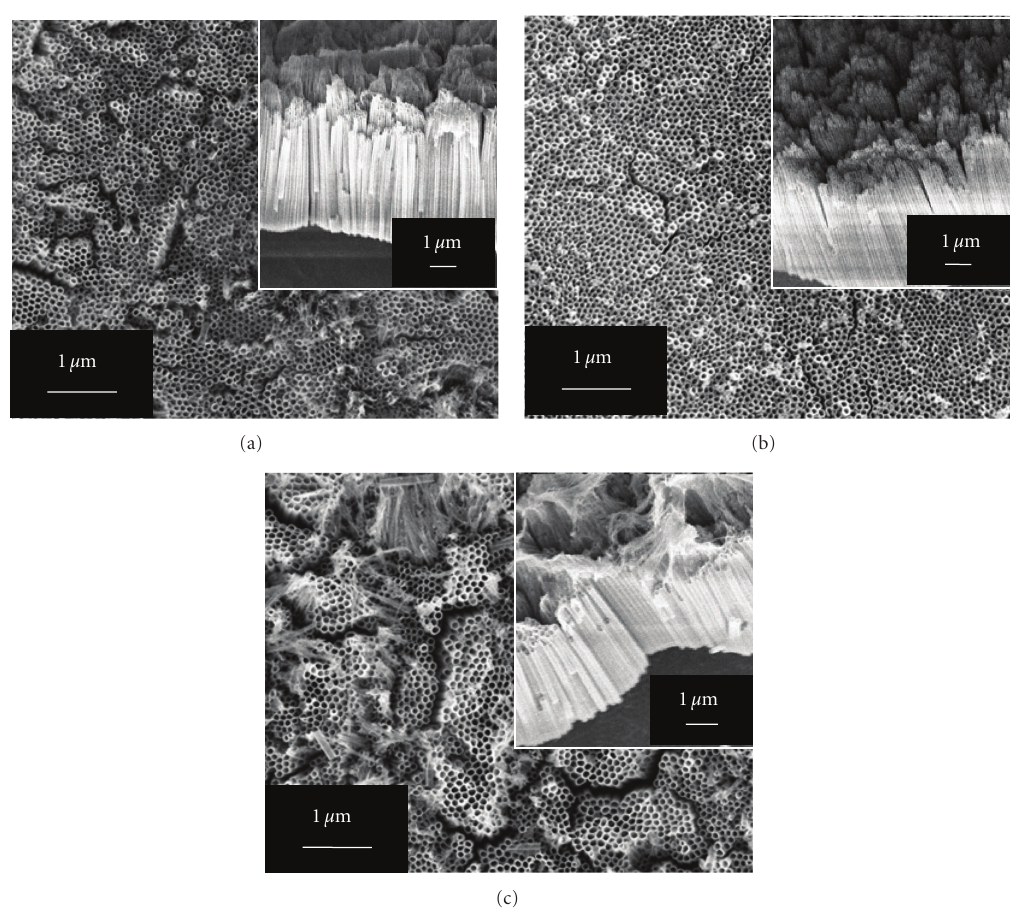
Figure 9: FESEM images of TiO 2 nanotubes obtained via ultrasonic cleaning using acetone after anodization for (a) 1, (b) 2, and (c) 10 min.